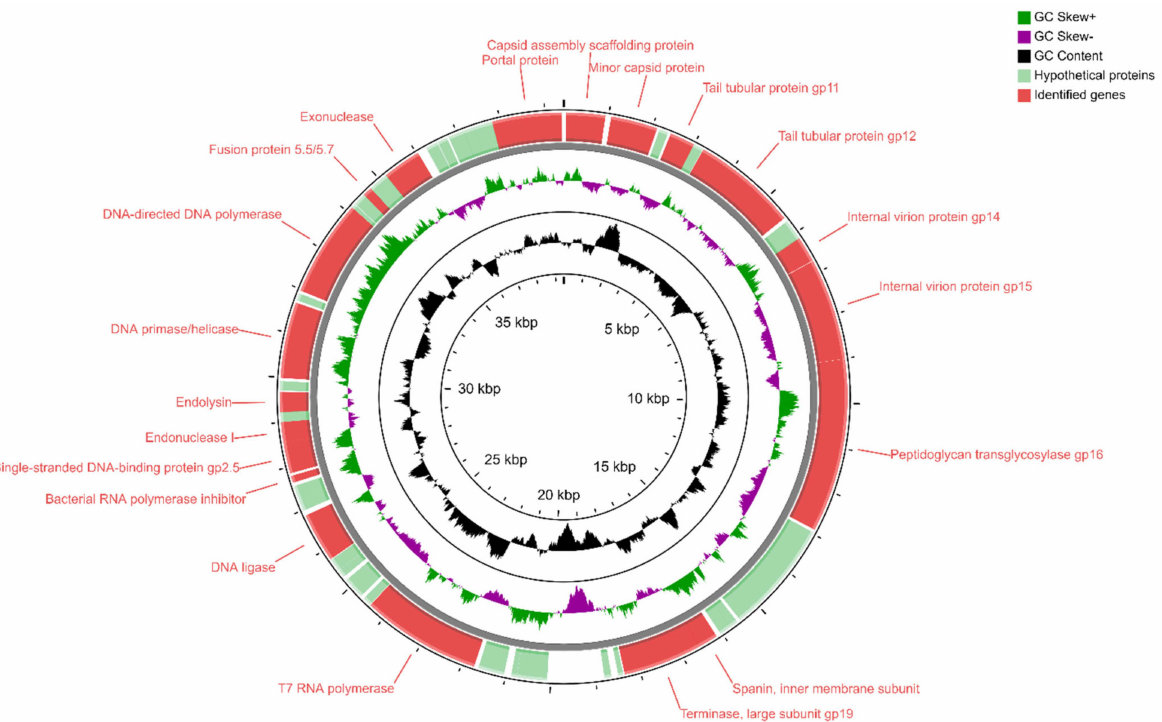
Figure 6. Map of the genome organization of Enterobacter phage KKP 3263 generated using the CGView program